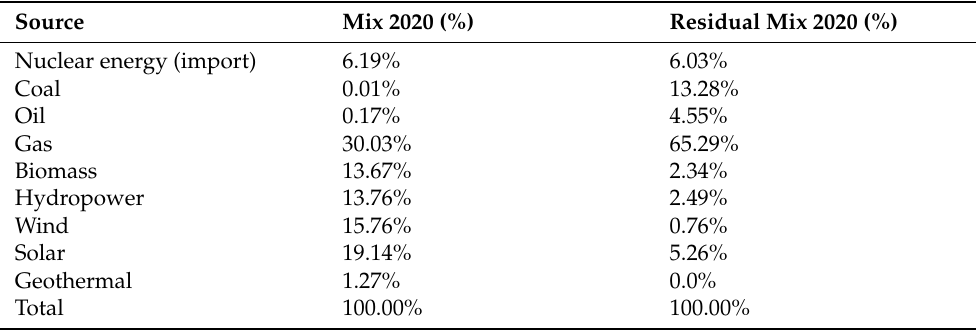
Table 5. Comparison of the Italian mix vs. the residual Italian